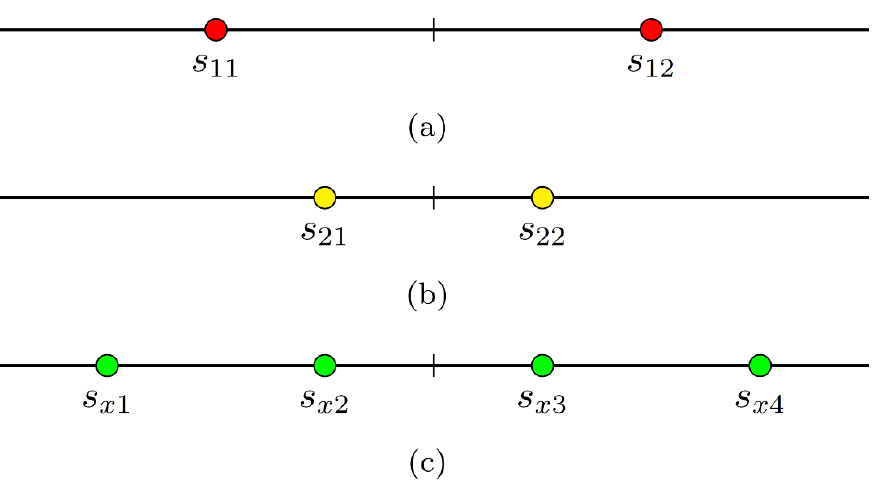
Figure 4. The signal constellation of: ( a ) weak user ( u 1 ), ( b ) strong user ( u 2 ), and ( c ) superposed transmitted signal ( x